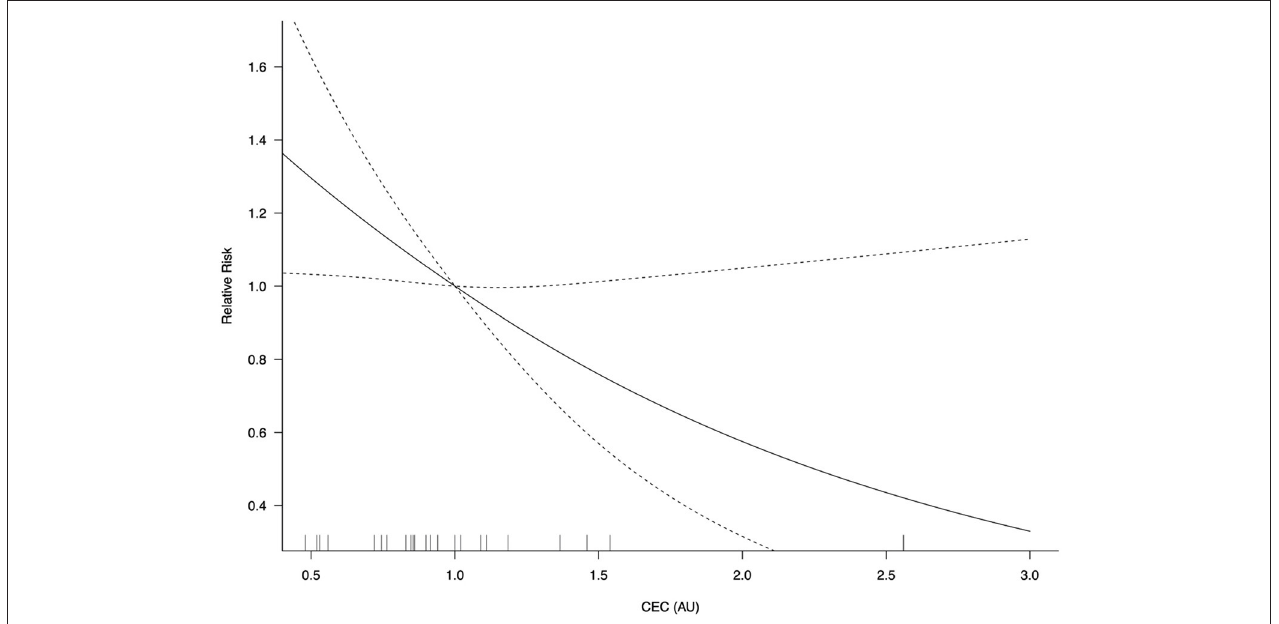
FIGURE 4 | CEC-adverse cardiovascular event relative risk relationship ( P = 0.024). AU, arbitrary unit; CEC, cholesterol efflux capacity; CI, confidence interval. Log-transformed CEC was used.